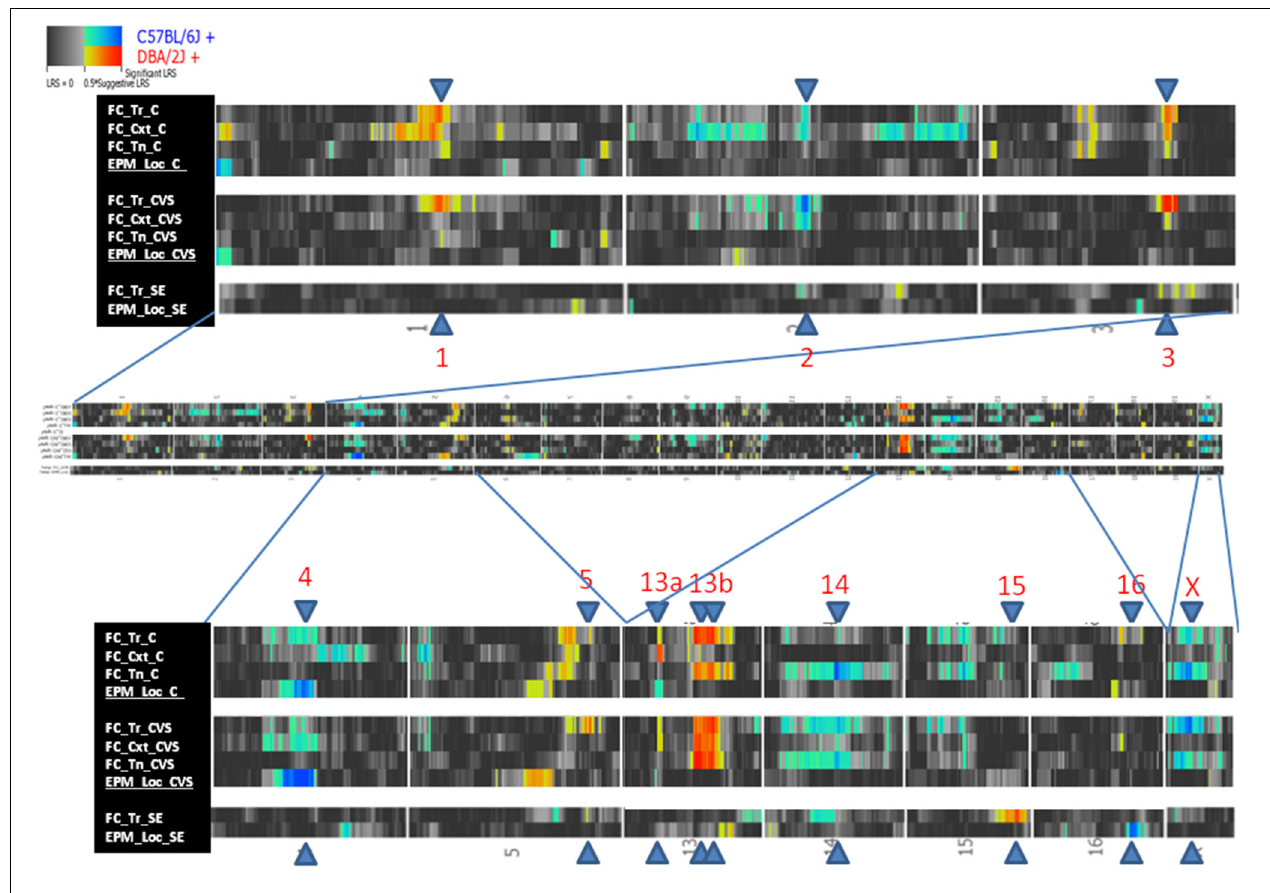
FIGURE 4 | Heatmap of QTL mapping of behavioral traits and Stress-Effect containing significant and/or suggestive peaks. Abbreviations in legend: Fear Conditioning (FC), elevated plus maze, (EPM),